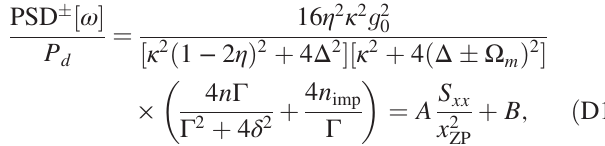
¼ ω (cid:1) Ω . A probe is 1 ; 2 m ; 2